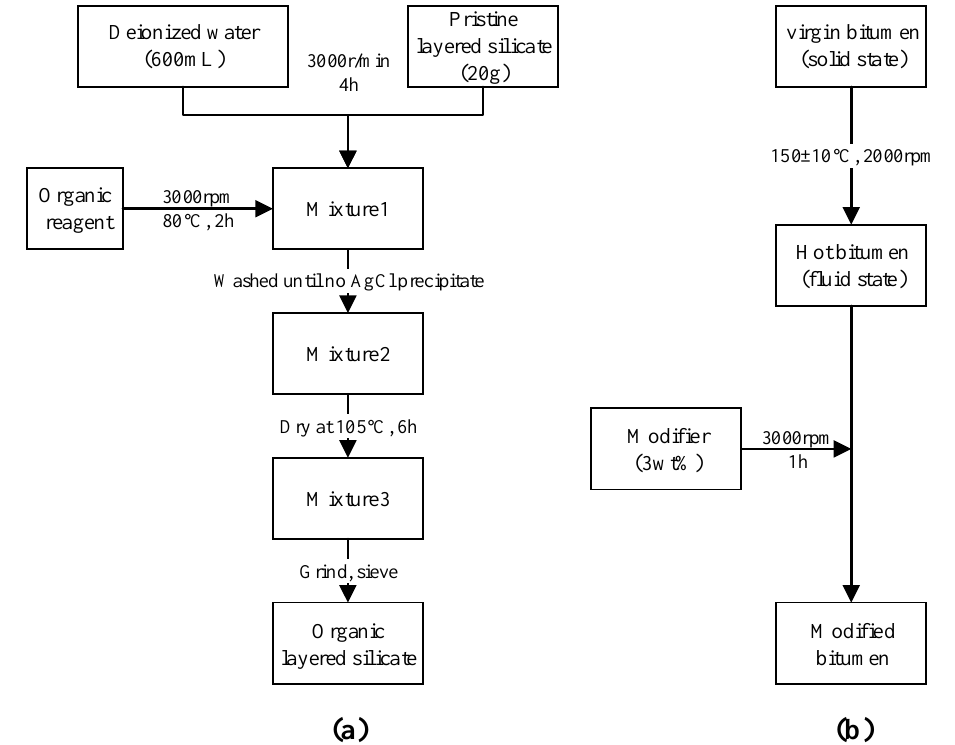
Figure 1. The preparation process of samples: ( a ) Organic layered silicates; ( b ) modified